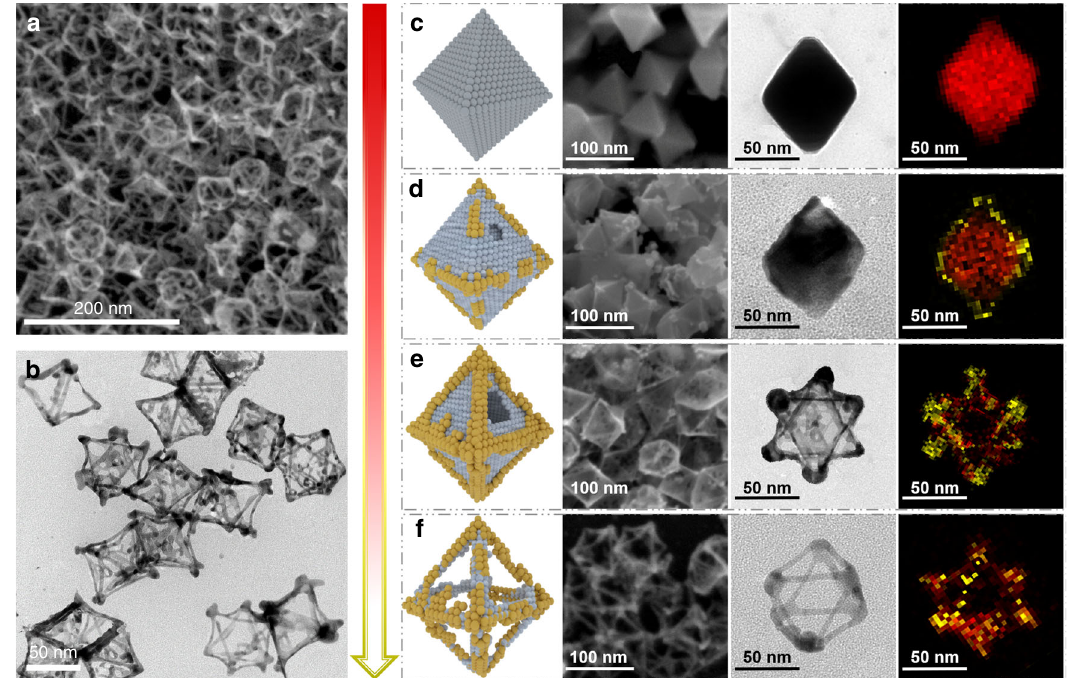
Fig. 1 Morphological evolution of Ag nanoparticles to Au 3 Ag nanoframes. a Scanning electron microscopy (SEM) and b transmission electron microscopy (TEM) overview of Au 3 Ag NFs showing high structural uniformity. The schematic diagram, SEM, TEM, and energy-dispersive X-ray (EDX) mapping images of c Ag NPs collected at the 36th min before HAuCl 4 addition, d AuAg 12 NPs collected at the 38th min after HAuCl 4 addition, e Au 2 Ag NCs collected at the 42th min, and f Au 3 Ag NFs collected at the 46th